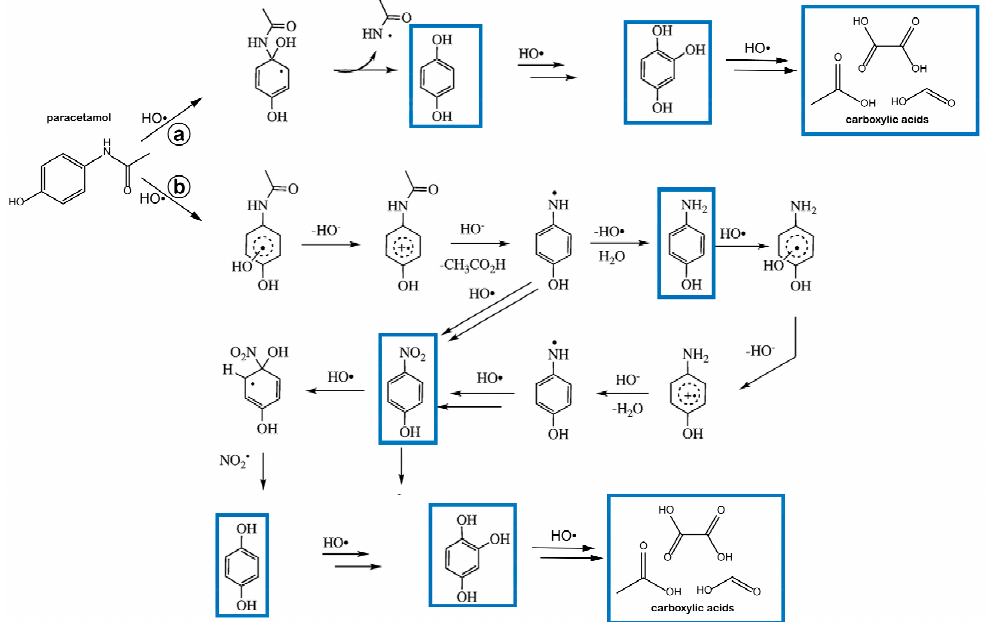
Figure 6. UV-Vis spectra of the starting 0.01 mM paracetamol solution and of the supernatant aliquots withdrawn after 1, 2, 3, 4, and 5 h solar illumination with the following samples: Comm_A, Comm_R, Comm_B, P25, and Lab_A. The photocatalyst concentration was 1.0 g L − 1 . The written wavelengths indicate some bands due to the formation of possible by-products based on Scheme